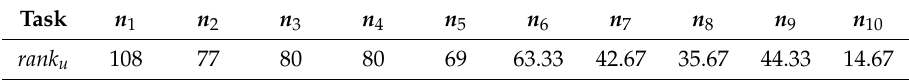
Table 3. Upward rank values for tasks of the application in Figure